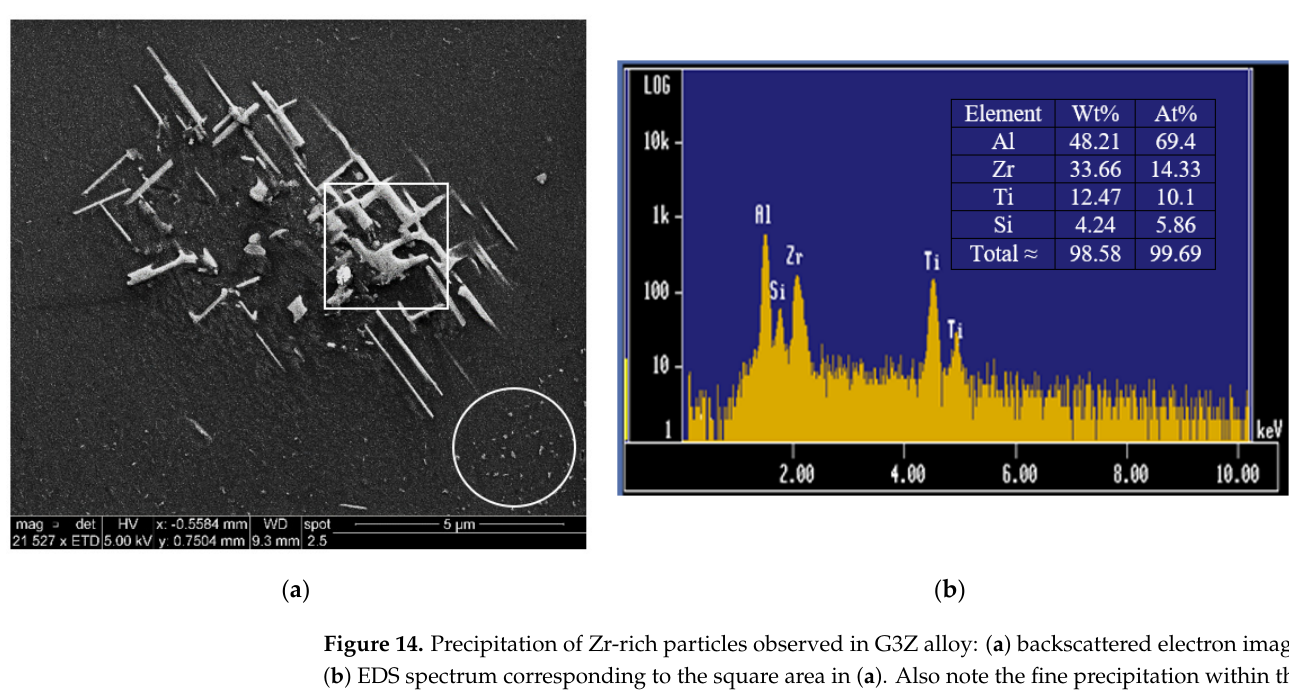
Figure 14. Precipitation of Zr-rich particles observed in G3Z alloy: ( a ) backscattered electron image, ( b ) EDS spectrum corresponding to the square area in ( a ). Also note the fine precipitation within the circled area in ( a ).